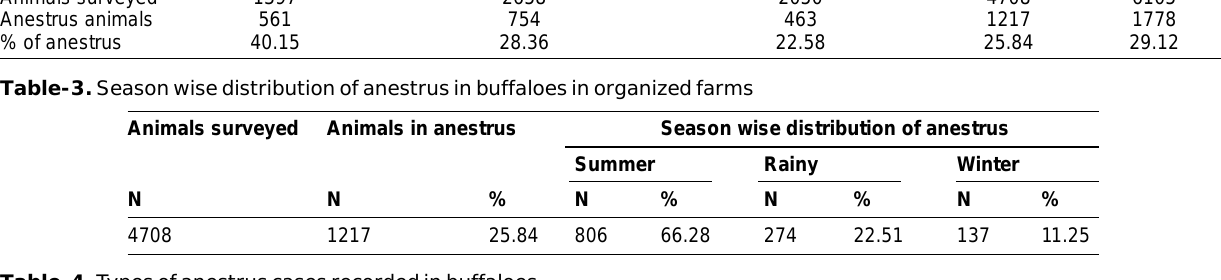
Table-4. Types of anestrus cases recorded in buffaloes Animals examined True